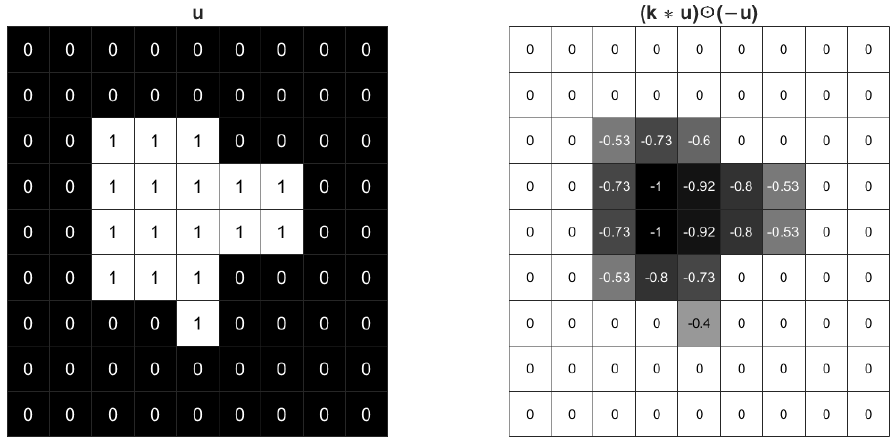
Figure 2. The effect of a 3 × 3 Gaussian kernel with σ = 1 for an image.